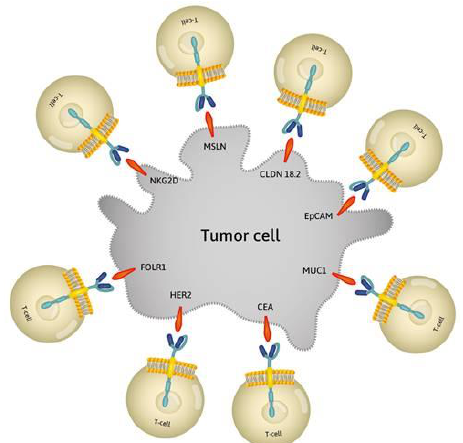
Figure 1. Effective targets for CAR-T immunotherapy. Modified T-cells to recognize target antigens: HER2, CEA, MUC1, EpCAM, CLDN 18.2, MSLN, NKG2D, and FOLR1 on tumor cell. HER2: human epidermal growth factor receptor 2; CEA: carcinoembryonic antigen; MUC1: mucin 1; EpCAM: epithelial cell adhesion molecule; CLDN 18.2: claudin 18.2; MSLN: mesothelin; NKG2D: natural-killer receptor group 2, member D; FOLR1: folate receptor 1.